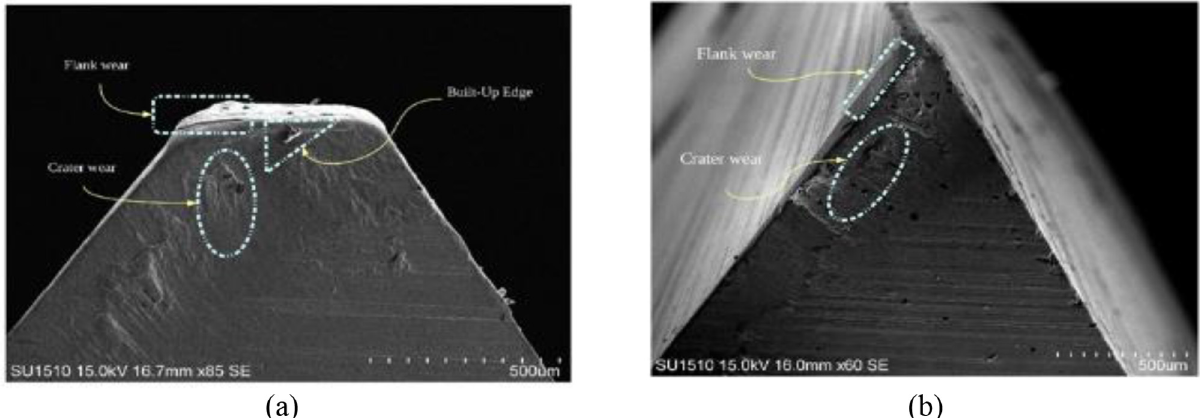
Fig. 7. Scanning electron microscopy images for analysis of fl ank wear in (a) untreated and (b)